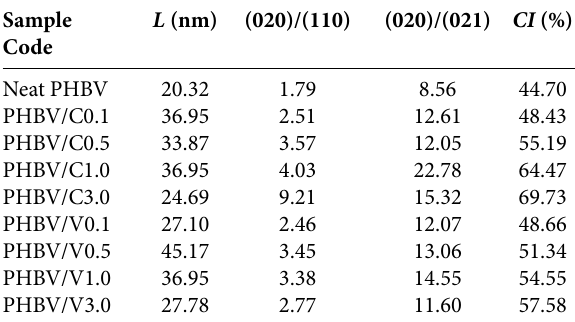
Table 2. L (nm), intensity ratios and CI (%) of neat PHBV and its composites from XRD scan